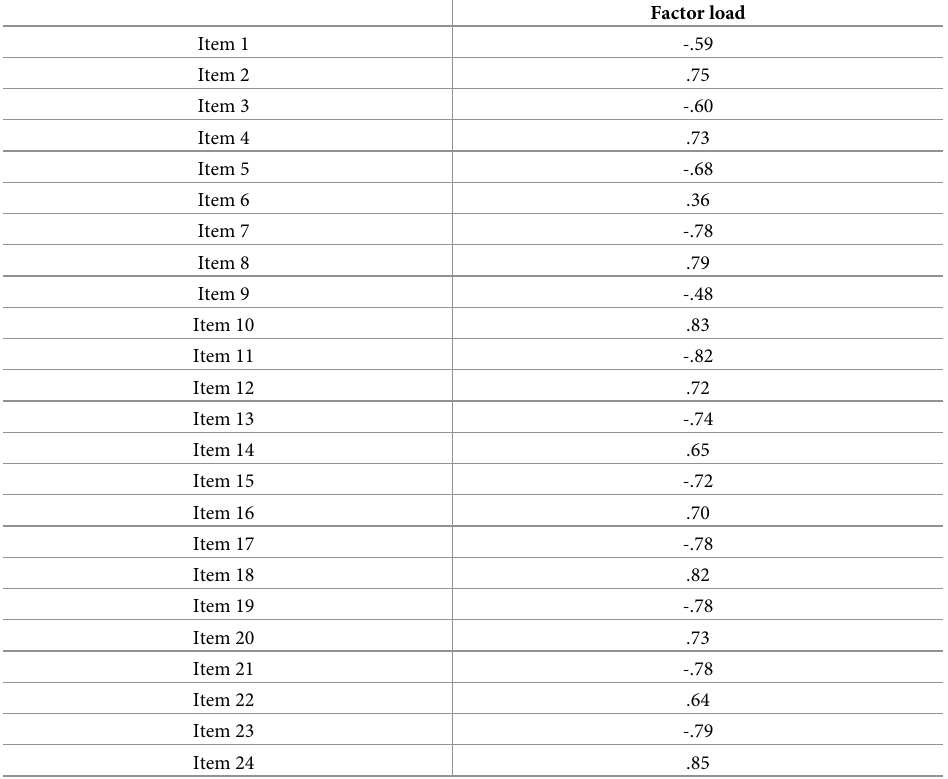
Table 2. EFA results: Items and factor loadings for the one-dimension structure of Personal Report of Communi- cation Apprehension